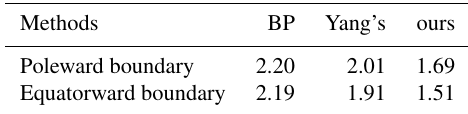
Table 2. The MAE values of different methods. Methods